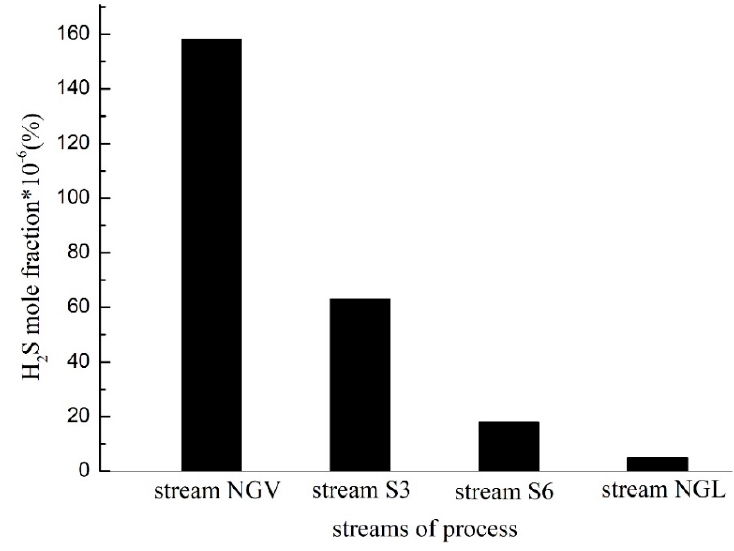
Figure 6. H 2 S decreases in liquid phase from stream NGV to stream NGL.